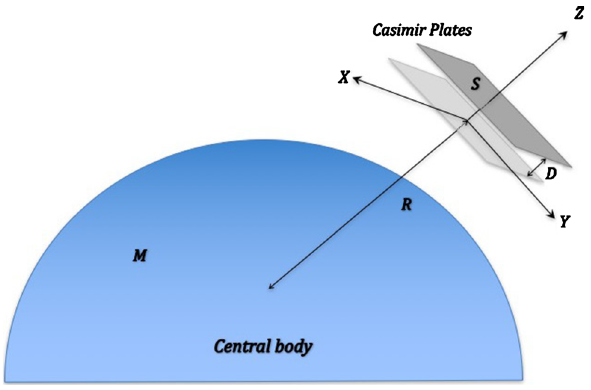
Fig. 1 The Casimir-like system in a gravitational field is represented above. Here, D denotes the distance between the plates, S their surface and R the distance from the source of gravity of mass M , with D < √ S (cid:4)